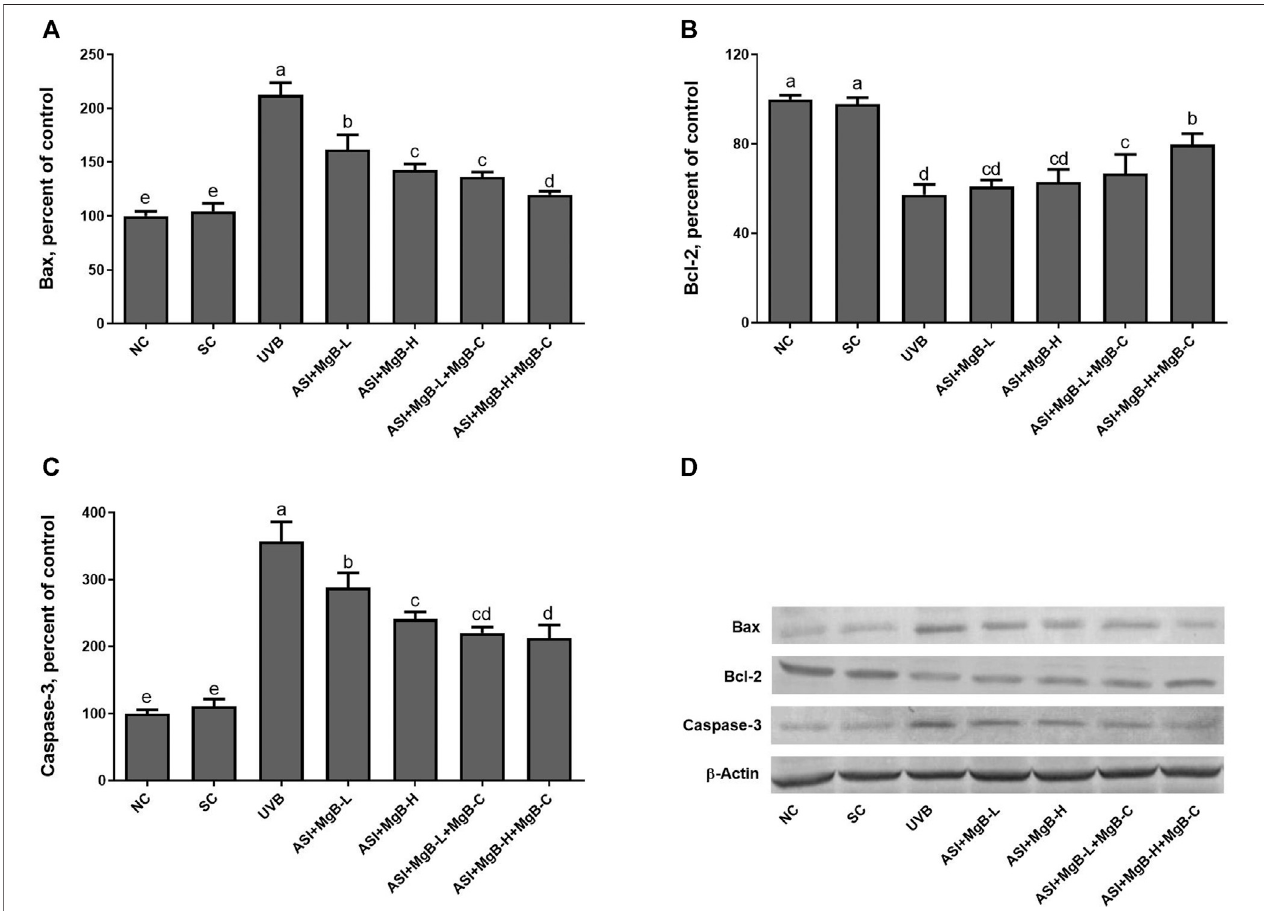
FIGURE7| Effectofinositol-stabilizedargininesilicatecomplex(ASI)andmagnesiumbiotinate(MgB)ontheBax (A) ,Bcl-2 (B) andcaspase-3 (C) levelsinratswith UVB-induced photoaging. Data are expressed as a percent of the control value. Each bar represents the mean and standard error of the mean. Blots were repeated at least3times.Westernblotanalysiswasperformedwithactinincludedensuringequalproteinloading (D) .Thedataarepercentagesofthecontrol. a – e :Valueswithinthe bars with different superscripts are signi fi cantly different (One-way ANOVA and Tukey ’ s post-hoc test, p < 0.05).